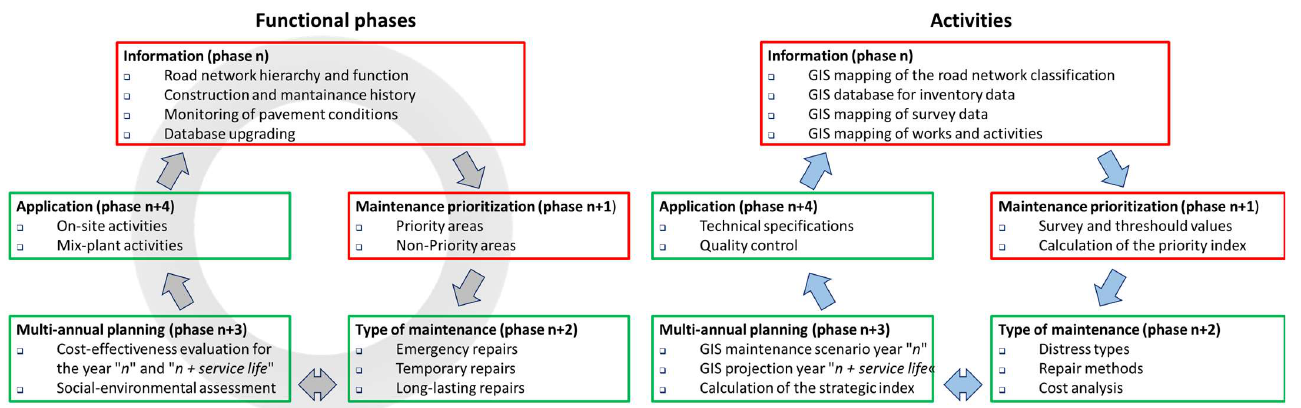
Figure 1. Functionality purposes and related actions (red boxes for network level, green boxes for project level). project